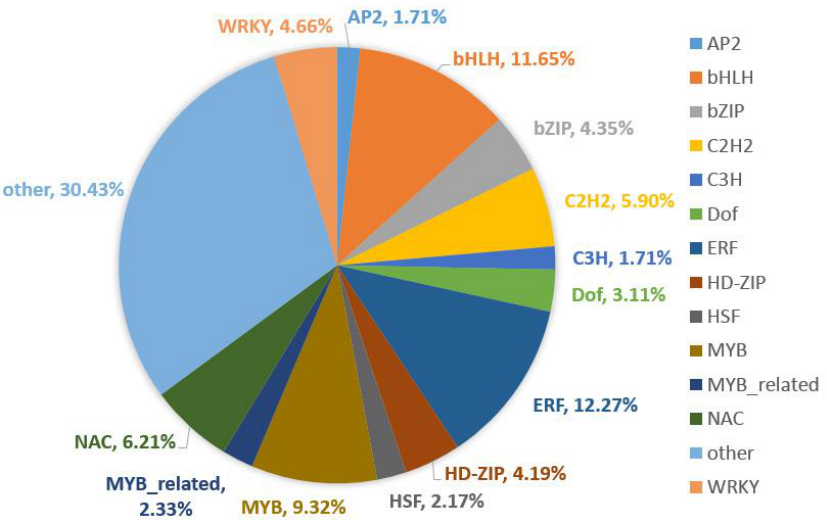
Figure 6. Distribution of differentially expressed TFs.